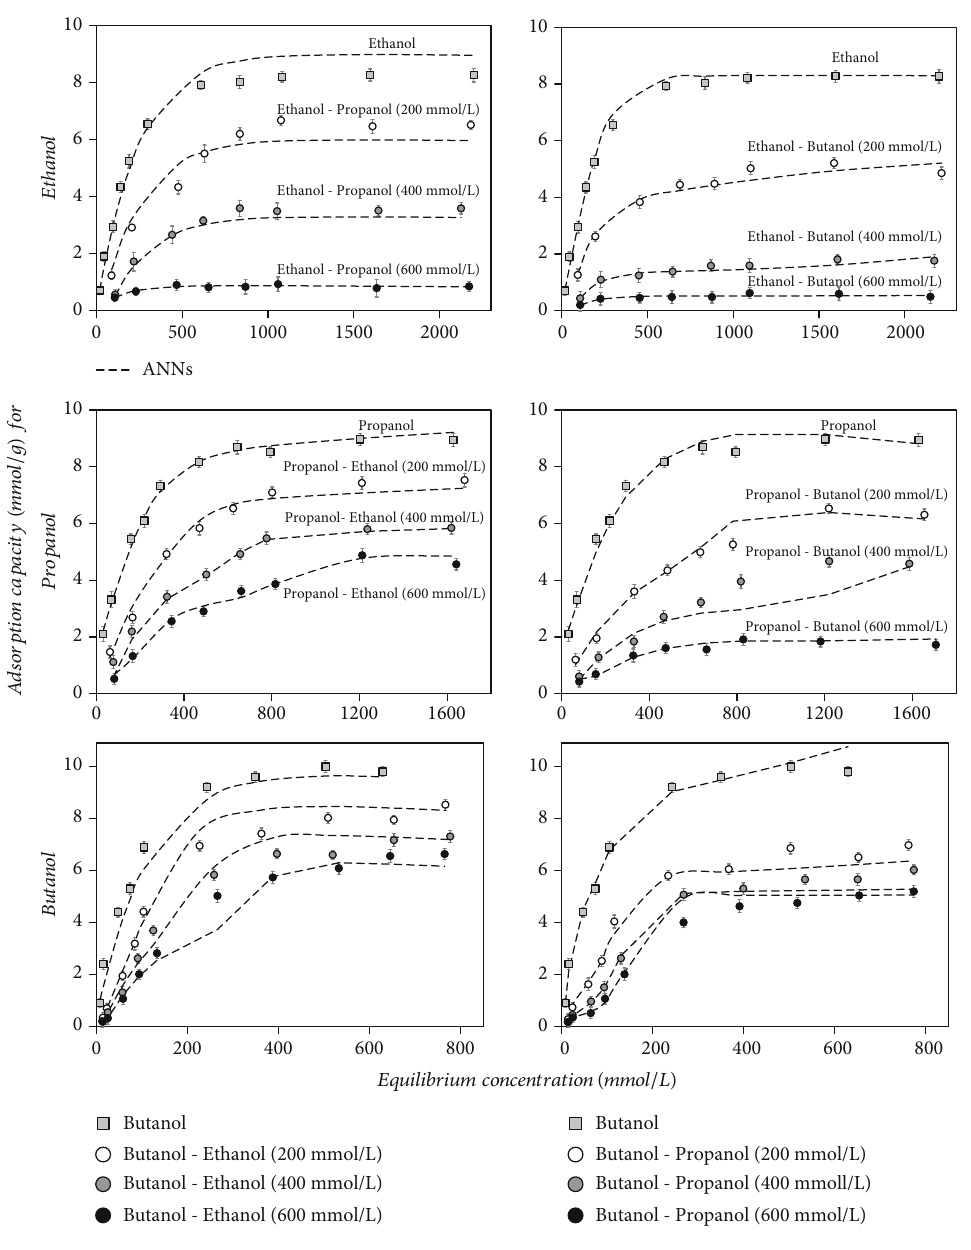
Figure 6: Binary adsorption isotherms of ethanol, propanol, and butanol on bone char in aqueous solutions at pH 6 and 20 ° C and its modeling with an arti fi cial neural